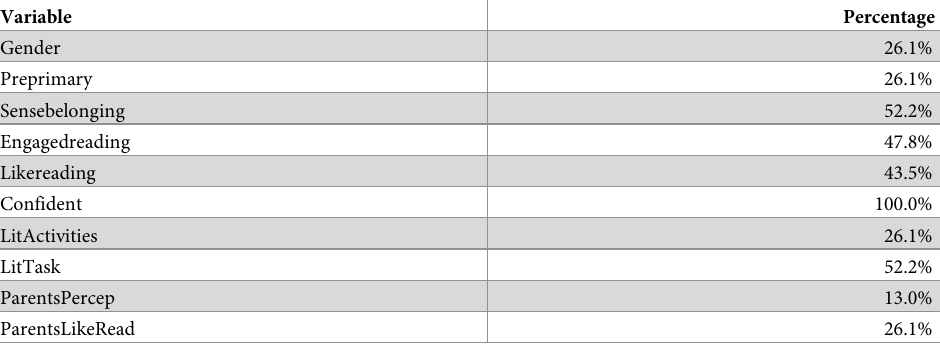
Table 7. Percentage of countries where the coefficient was significant for student and family contextual variables.